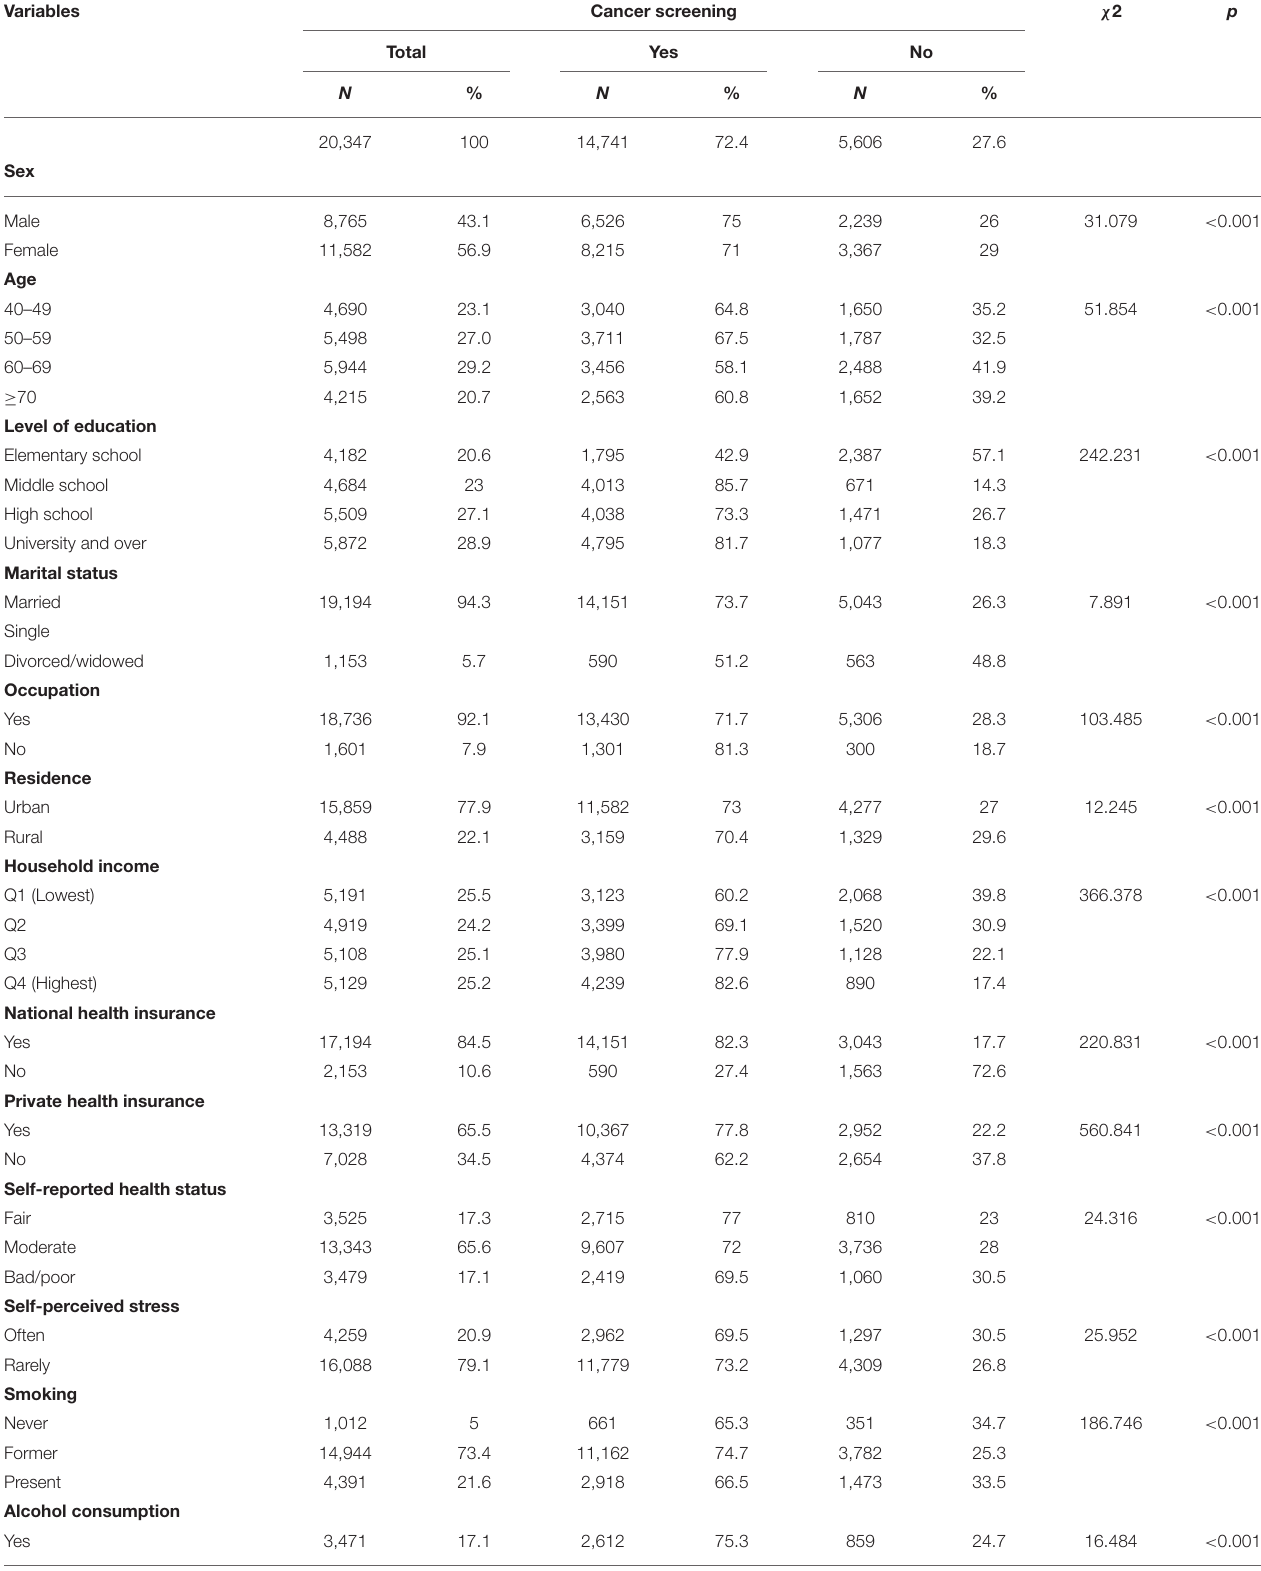
TABLE 1 | Distribution of cancer screening based on general characteristics of participants. Variables Cancer screening χ